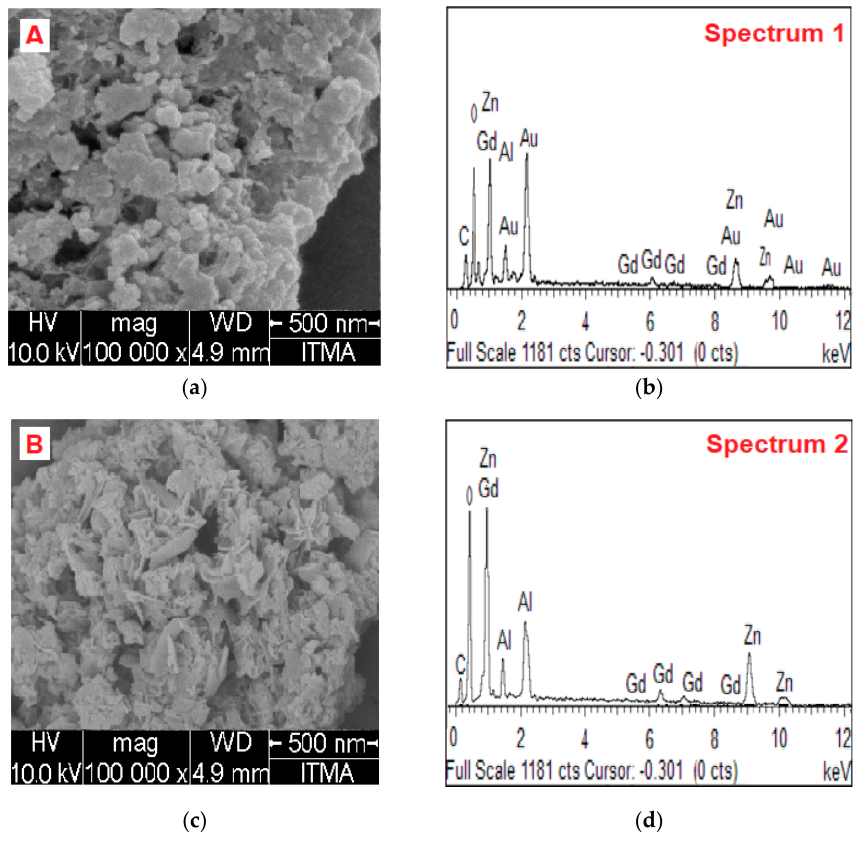
Figure 3. ( a ) Field emission scanning electron microscopy (FESEM) micrograph (A) and ( b ) Energy dispersive X-ray (EDX) spectrum (1) of gallic acid intercalated in LDH/Gd nanoparticles coated with AuNPs (GAGZAu); ( c ) micrograph (B); and ( d ) EDX spectrum (2) of gallic acid intercalated in LDH/Gd nanoparticles (GAGZA).